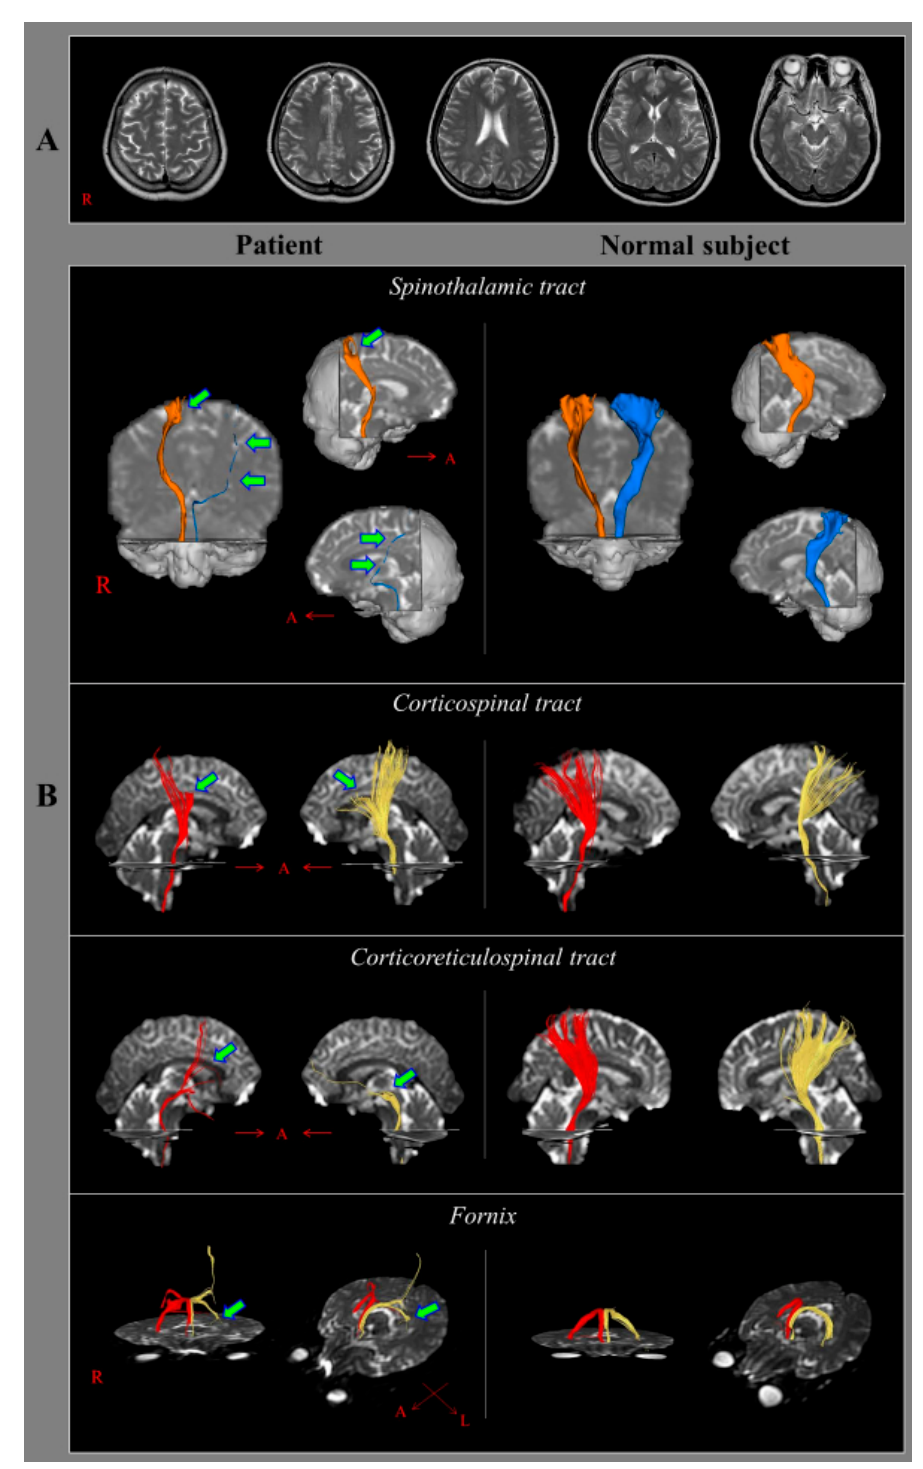
Figure 1. ( A ) T2-weighted brain magnetic resonance images at nine years after whiplash injury onset shows no abnormality. ( B ) Results of diffusion tensor tractography of the patient at nine years after injury compared to those from a normal subject (42-year-old female). The left spinothalamic tract shows marked narrowing (green arrows) while the right spinothalamic tract reveals mild narrowing and partial tearing in the upper portion (green arrow). In addition, partial tears at the subcortical white matter (green arrows) are visible in both corticospinal tracts and the right